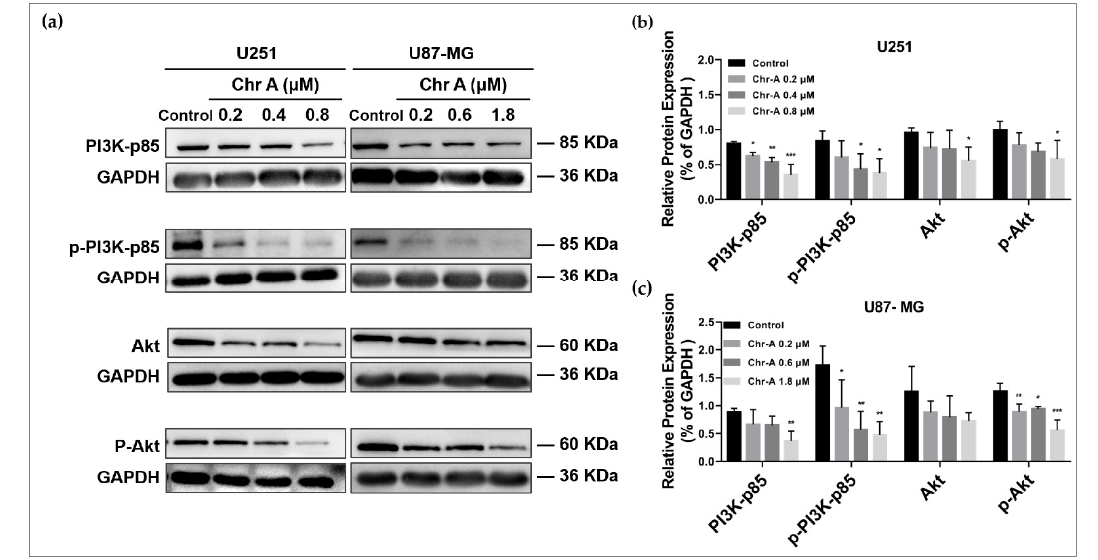
Figure 4. Chr-A regulates PI3K/Akt pathway in the U251 and U87-MG cells. ( a ) Western blot shows that Chr-A downregulated PI3K-p85, Akt, p-PI3K-p85 and p-Akt in the U251 and U87-MG cells. ( b ) Relative protein expression of PI3K-p85, Akt and their phosphorylated forms in the U251 cells. ( c ) Relative protein expression of PI3K-p85, Akt and their phosphorylated forms in U87-MG cells. Data are demonstrated as mean ± SD ( n = 4), * p < 0.05, ** p < 0.01 and *** p < 0.001 vs. the control group.